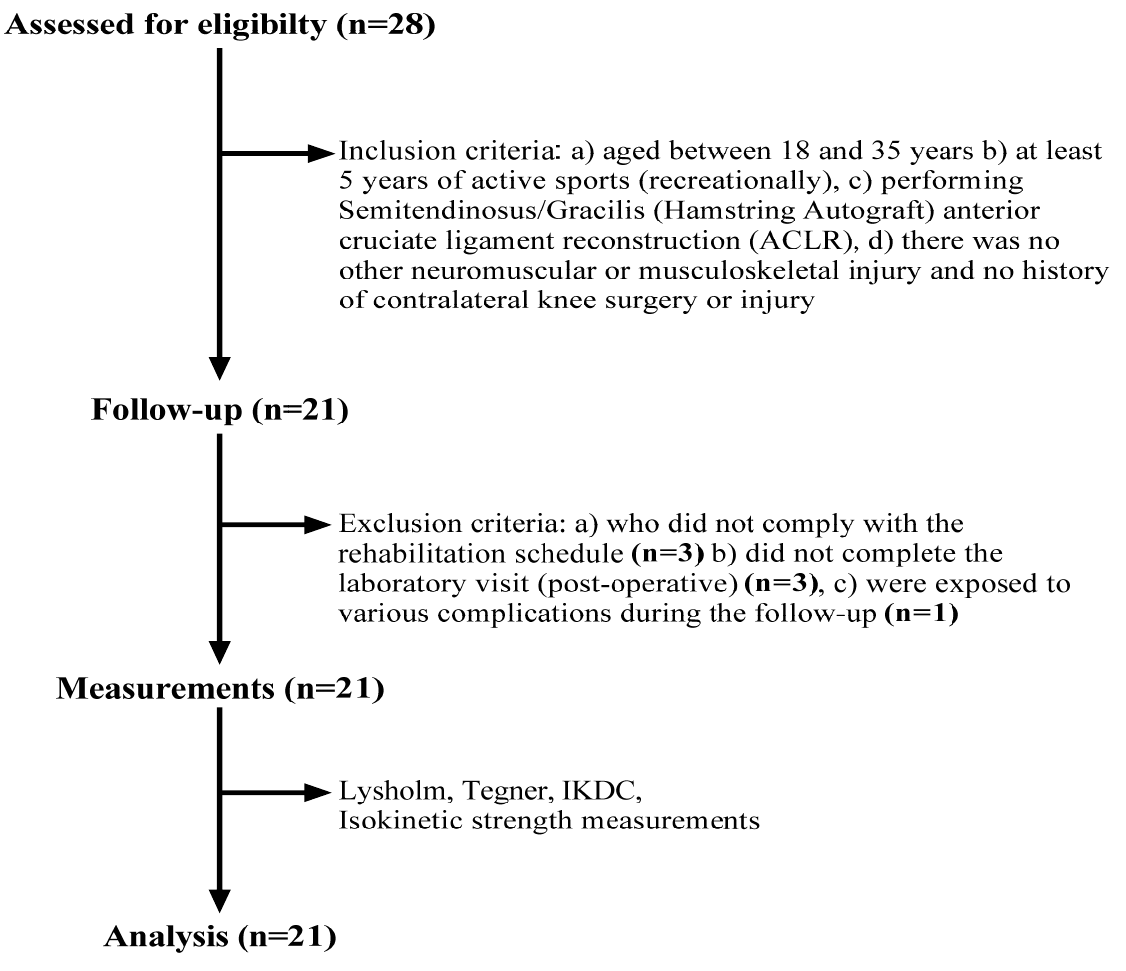
Figure 1. Flow chart diagram: description of the study population and inclusion and exclusion cri- teria.